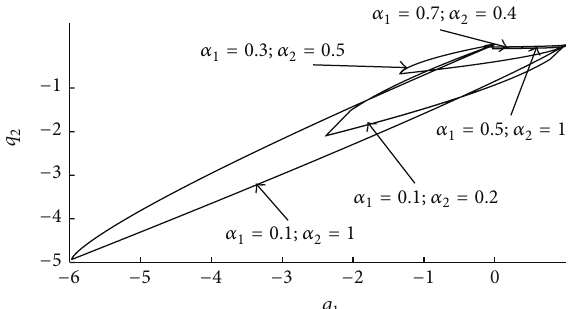
Figure 19: The phase trajectories in optimal control mode for Caputo double integrator.